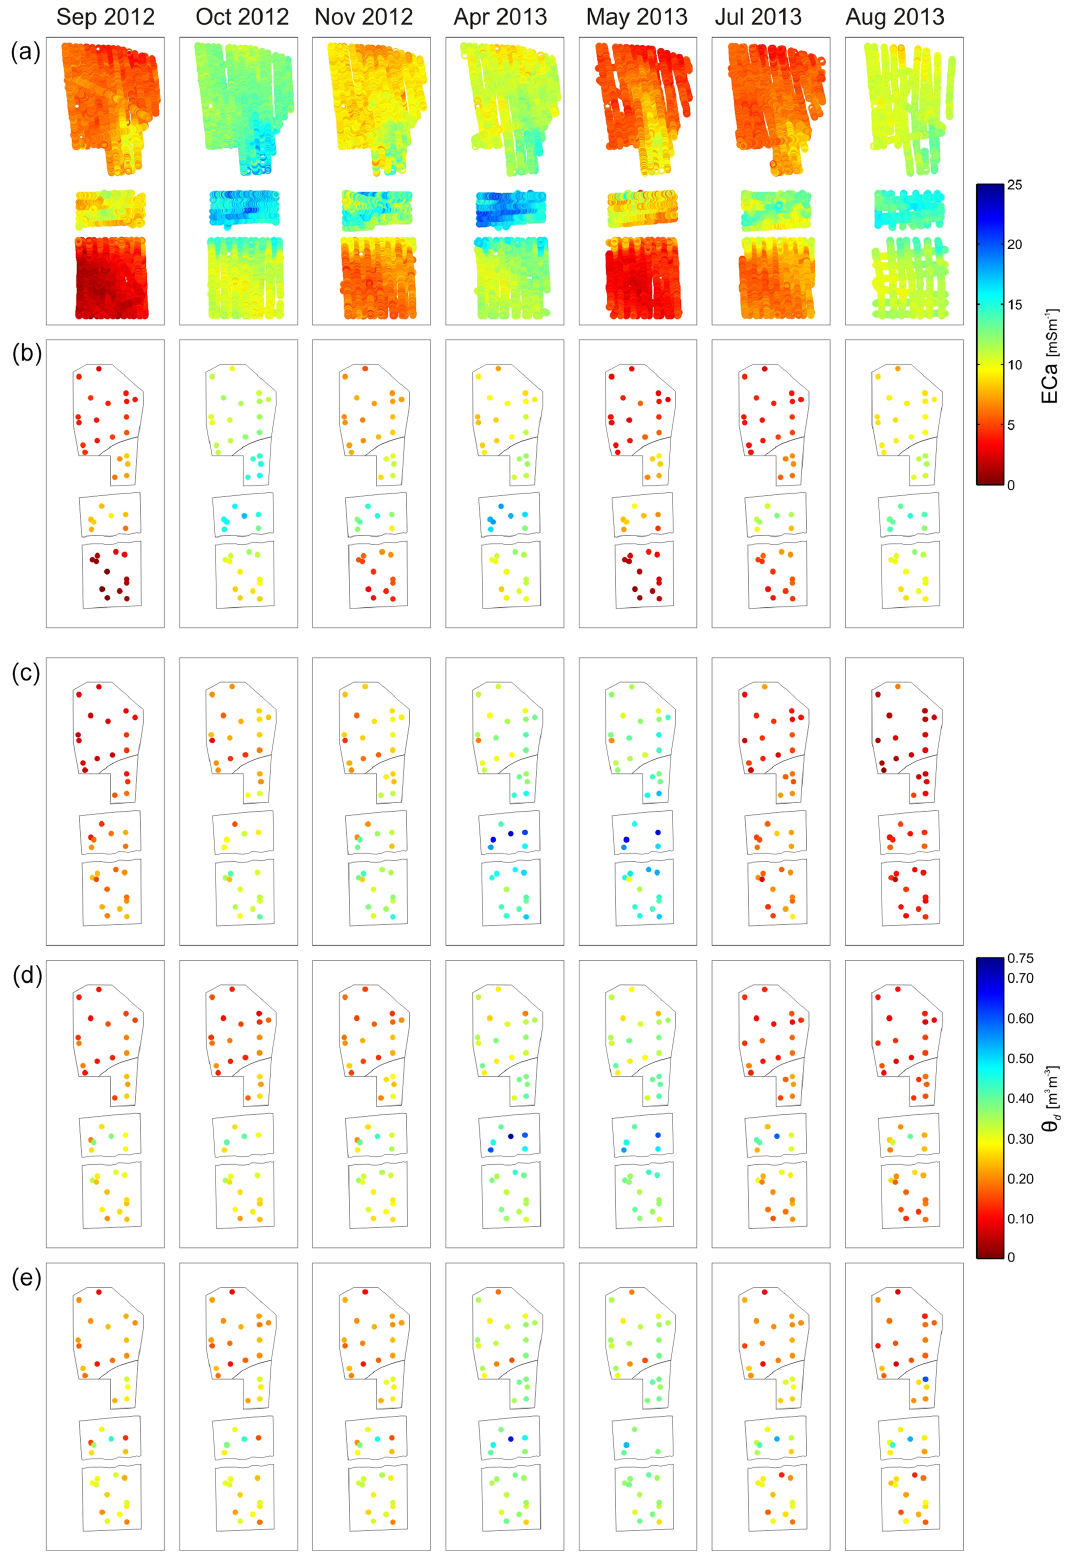
Figure 3. Spatial maps of (a) measured ECa (after processing); (b) extracted apparent electrical conductivity (ECa e ) for the positions of the 40 nodes of the soil moisture monitoring network; (c) daily mean soil moisture at 5cm ( θ d,05 ); (d) daily mean soil moisture at 25cm ( θ d,25 ); (e) daily mean soil moisture at 50cm ( θ d,50